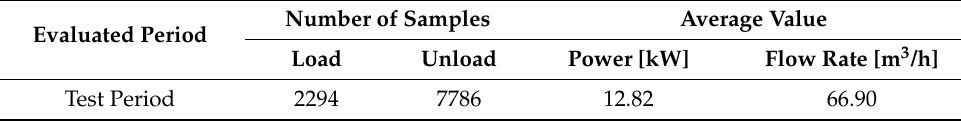
Table 5. Average air compressor power and flow rate during the test period from NILM Table 6. Comparison between leakage estimation from measurements and from NILM.